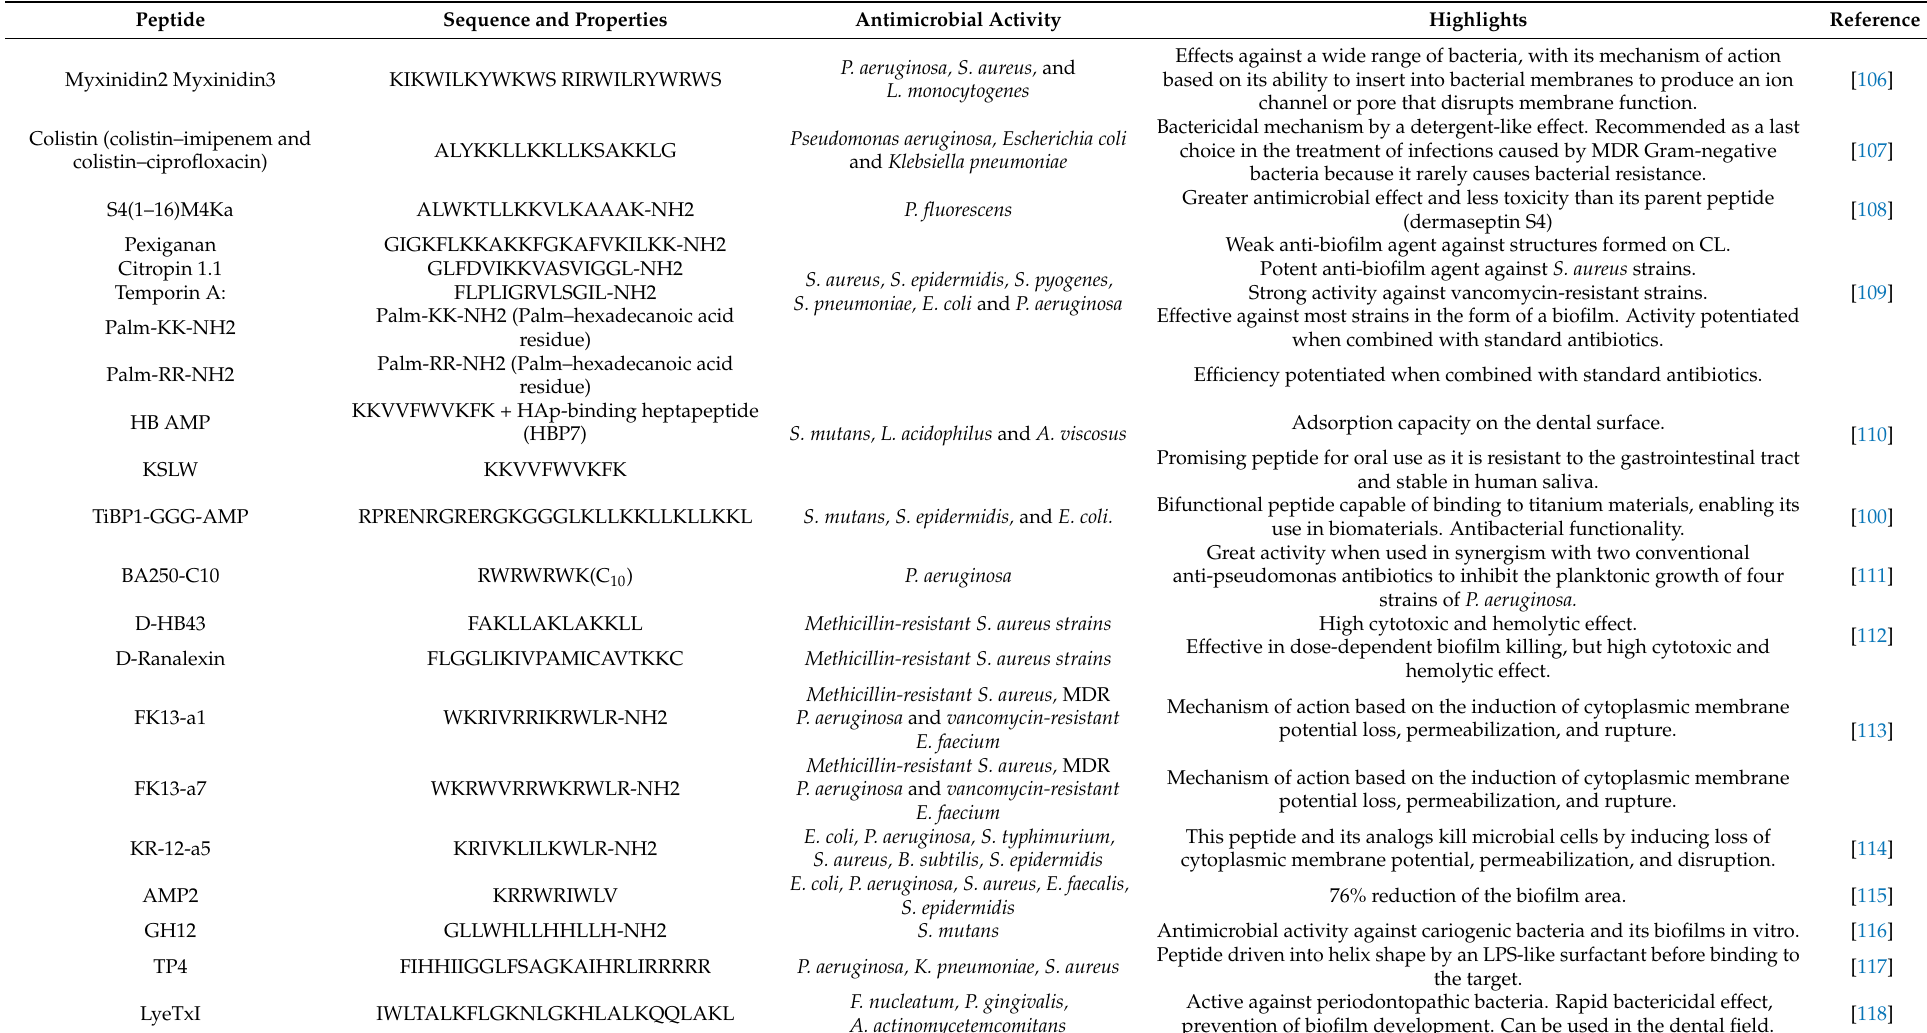
Table 3. Promising AMPs against biofilm formation, potential antibacterial properties, and highlights of the promising